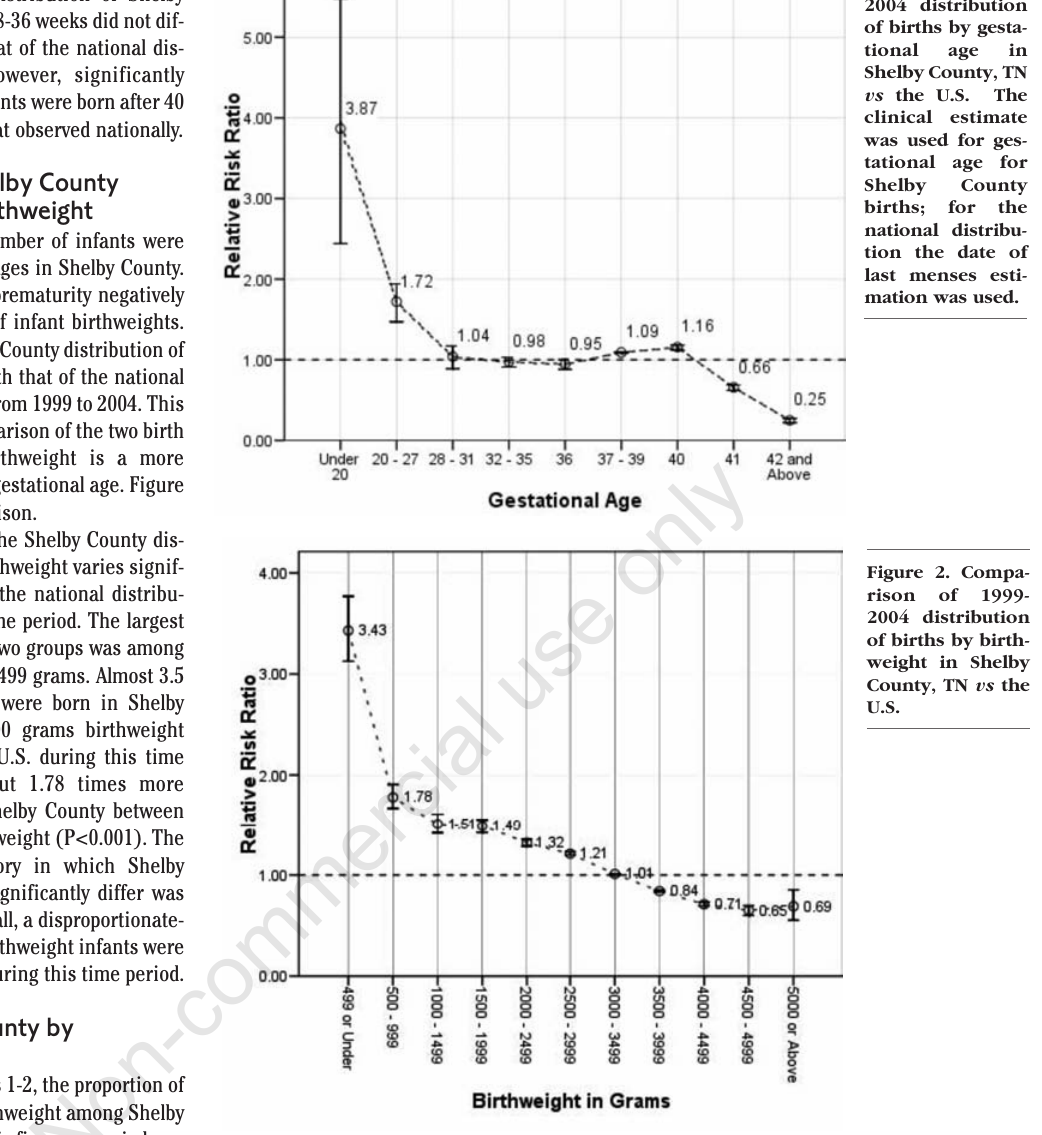
Figure 1. Compa- rison of 2003- 2004 distribution of births by gesta- tional age in Shelby County, TN vs the U.S. The clinical estimate was used for ges- tational age for Shelby County births; for the national distribu- tion the date of last menses esti- mation was used.